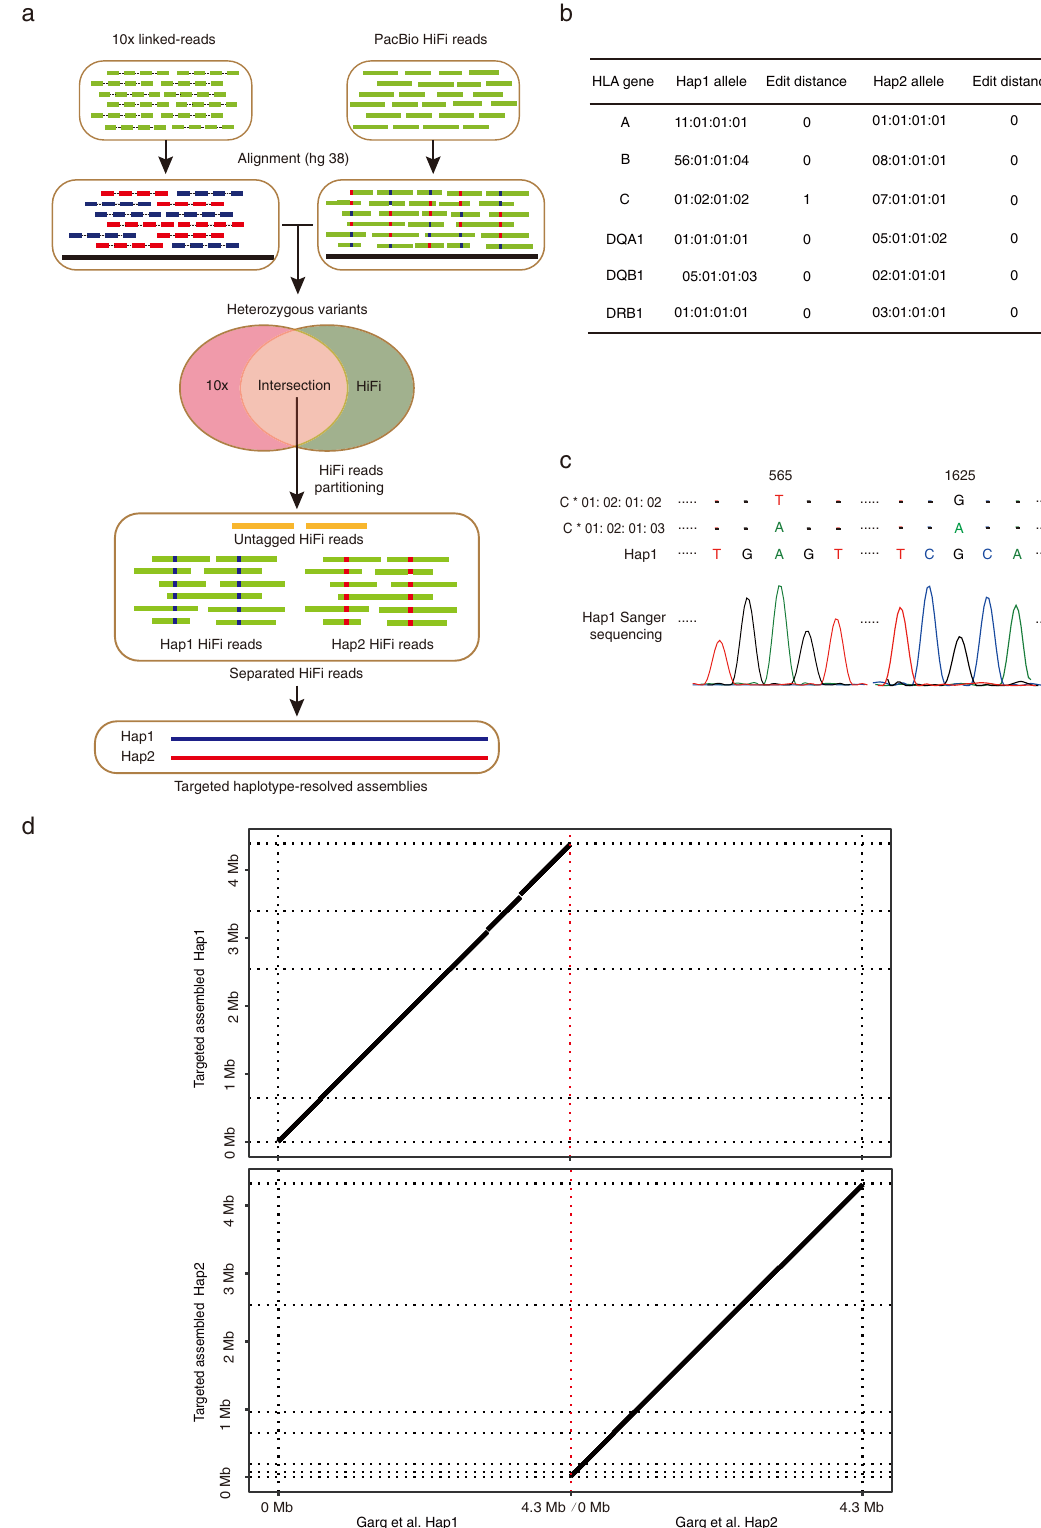
Fig. 2 | Targeted haplotype-resolved assembly of the MHC region and HLA typing. a Schematics of targeted haplotype-resolved assembly of the MHC region with 10x linked-read data and PacBio HiFi reads. b HLA typing of six classical HLA genes using the targeted haplotype-resolved assembly. Edit distance: the number ofdifferentnucleotidesbetweenourassembliesand thereported HLAallelesfrom the IMGT/HLA database. c A novel HLA-C allele in haplotype 1 is con fi rmed by